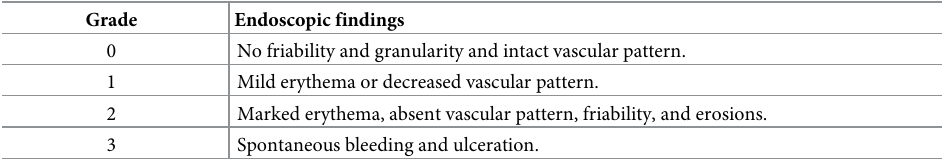
Table 1. Mayo endoscopic subscore